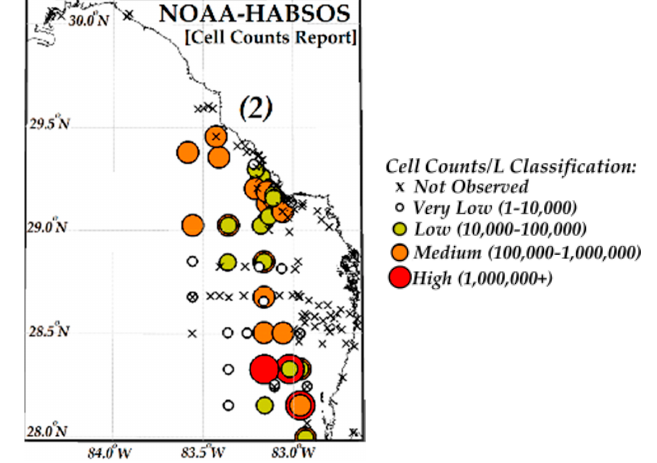
Figure 2. NOAA HABSOS data [37] with in situ KB concentrations, for period 8 August–17 September 2014 .